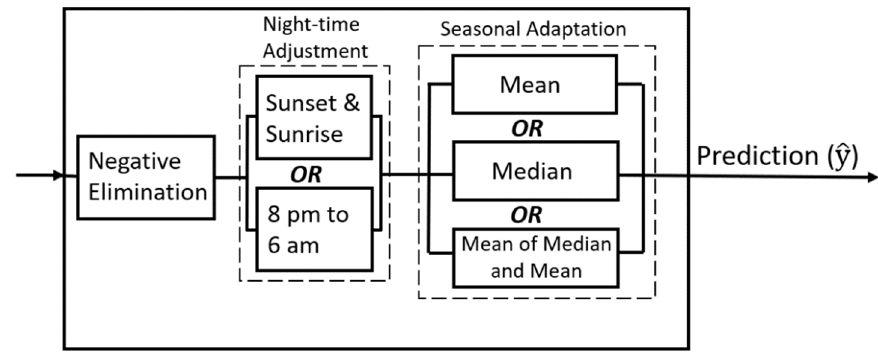
Figure 4. Contextual optimisation block diagram showing the three main steps. FBP generated large negative values for both long- and short-term predictions. For all negative predictions (which only occurred in winter), the target value was zero. This shows that FBP only forecasted negative values during the night hours, as shown in Figure 5. In summer, all night hour predictions were positive. As there could not be negative irradiance and most negative predictions occurred at night, all negative values were eliminated and set to zero. The SVM model also predicted some negative values (around 5% for short-term and 50% for long-term). For most predictions with negative values, the target value was zero. For the non-zero target values, the radiation was very low (maximum of 15 W/m 2 ). Therefore, here too, all negative values were set to zero.